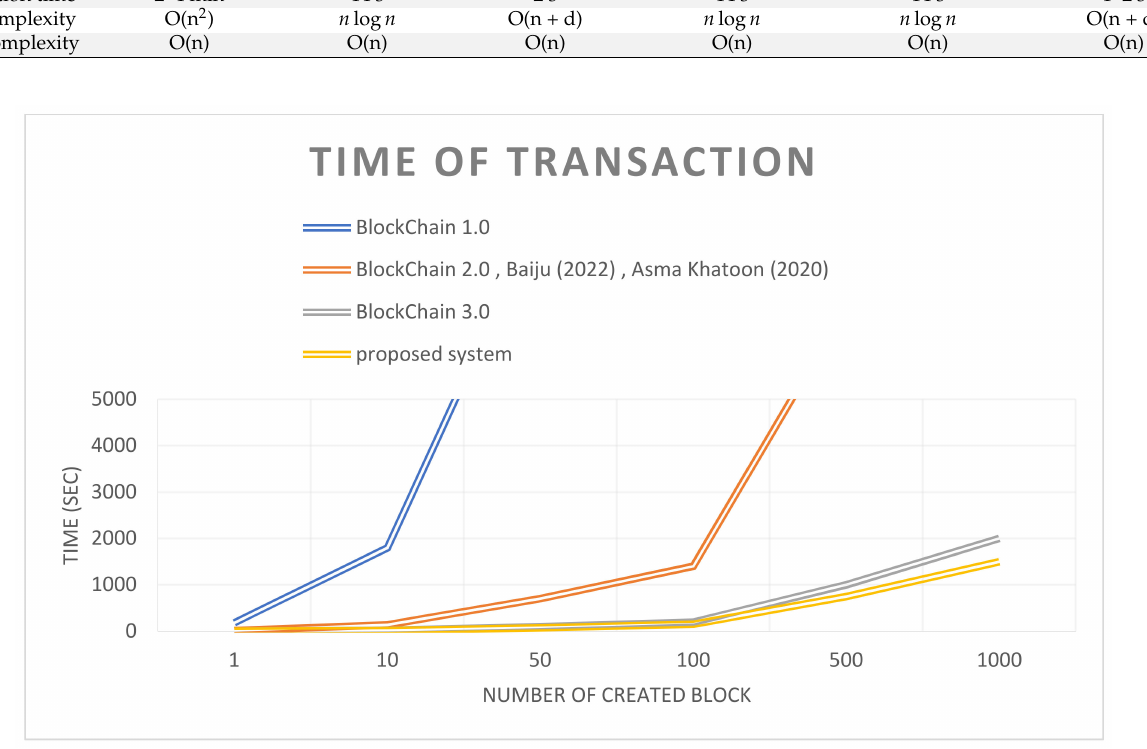
Figure 5. Time of